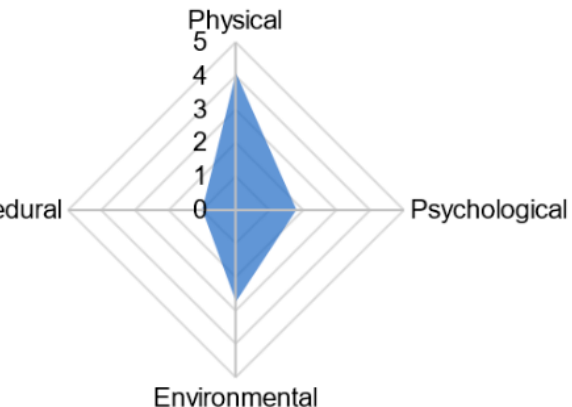
Figure 1. Radar chart illustrating visualization of animal welfare data by using averages of the four parameter classes of physical, procedural, environmental, and psychological to form a polygon. The CWAS is represented by the surface area of this chart. Reproduced from Brouwers, Stijn and Ducha- teau, Marie José 2021, “Feasibility and validity of the Animal Welfare Assessment Grid to monitor the welfare of zoo-housed gorillas Gorilla gorilla gorilla”. Journal of Zoo and Aquarium Research 9(4):208. Reprinted under a Creative Commons Attribution CC BY 4.0 license.